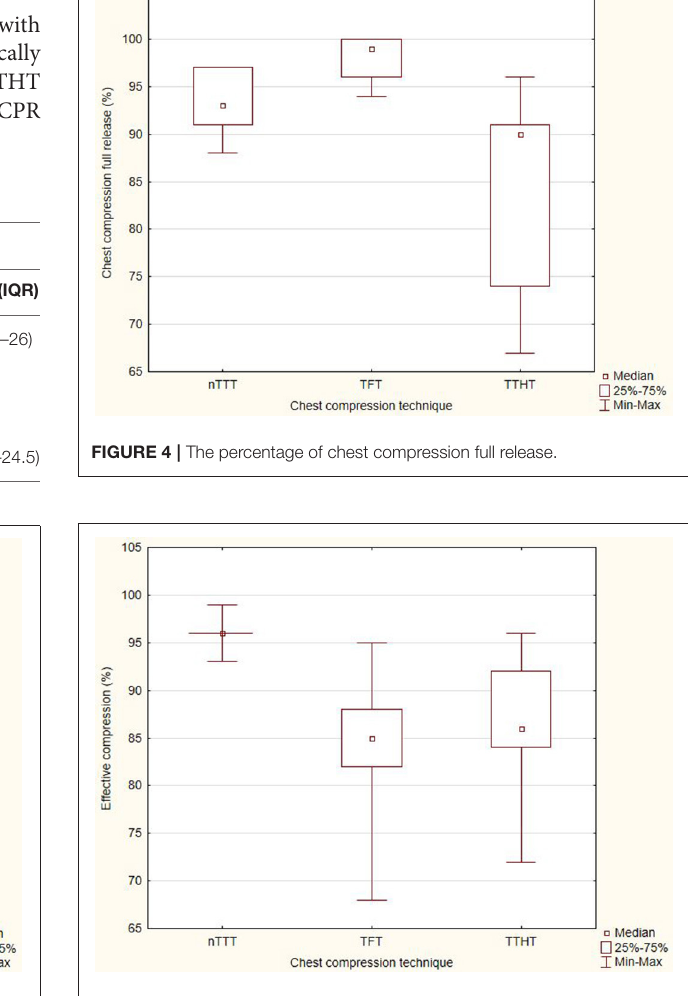
FIGURE 5 | The percentage of effective